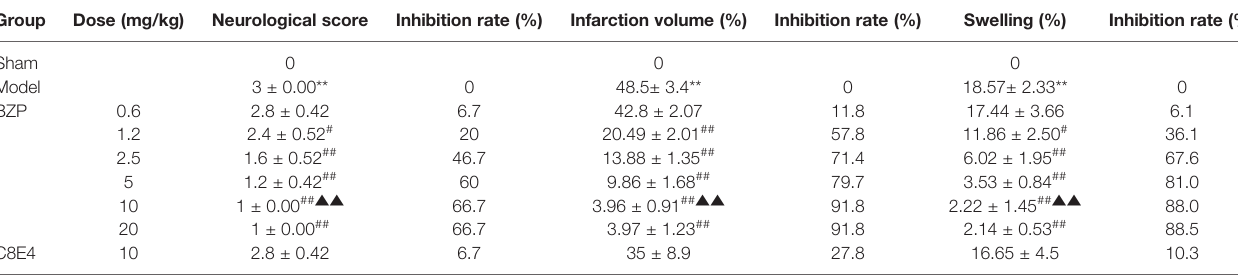
TABLE 1 | Effect of BZP on Neurological score, infarction volume, and brain swelling in MCAO rats. Group Dose (mg/kg) Neurological score Inhibition rate